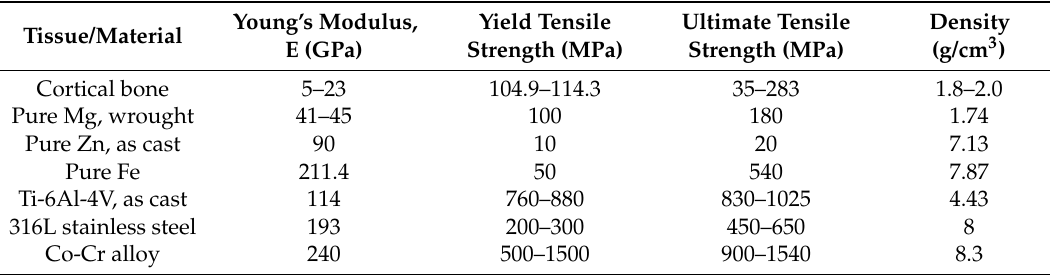
Table 1. Comparison of typical mechanical properties of cortical bone and commonly used metallic biomaterials, data from